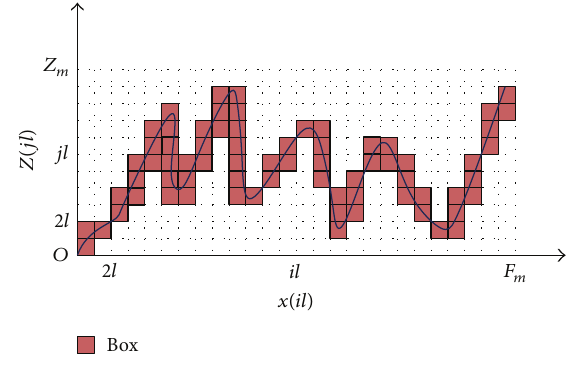
Figure 1: Covered boxes of cutting load time